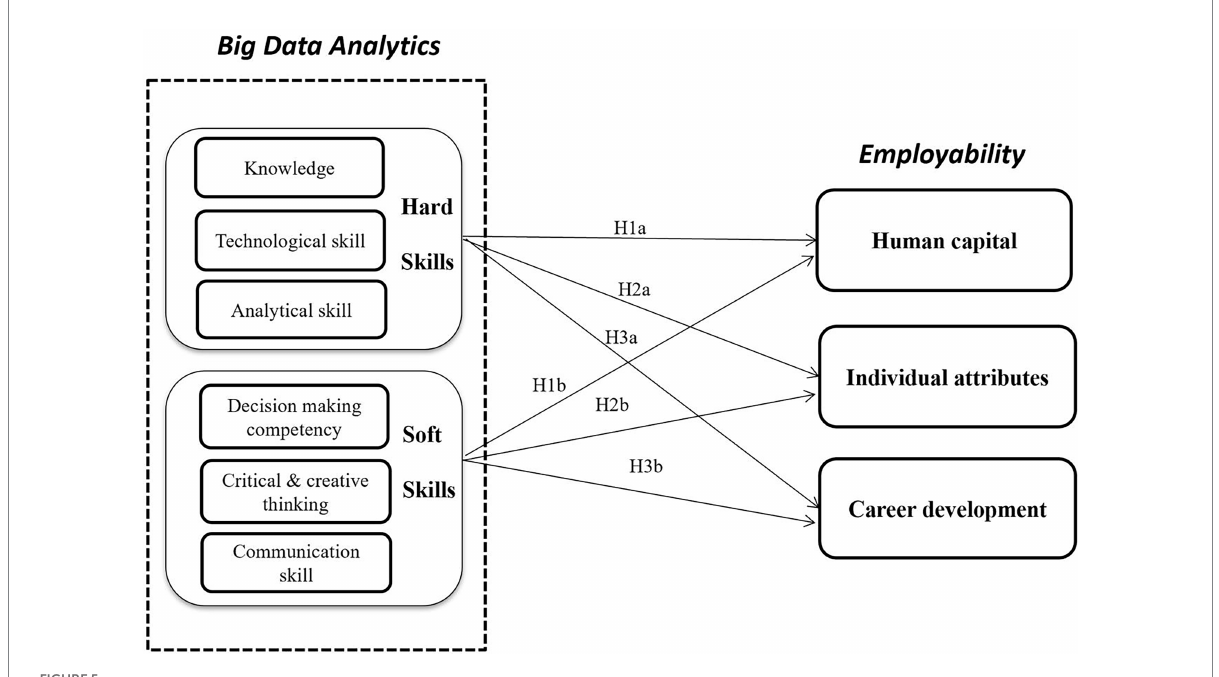
FIGURE 5 Conceptual model of BDA-E impact